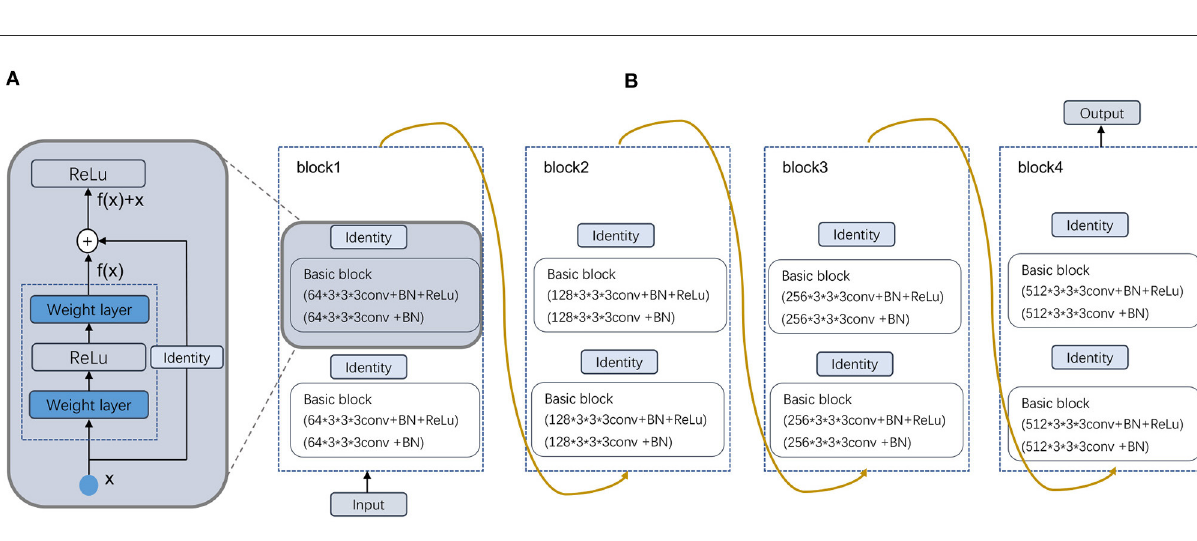
FIGURE2 Schematic illustration of the deformed feature extraction module. (A) Residual block and (B) Four Residual